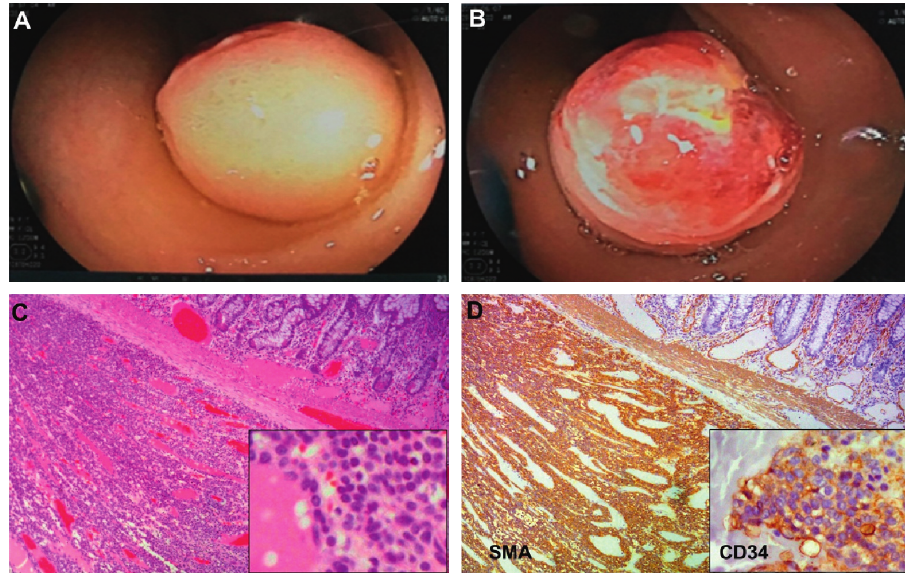
Figure 2: Representative images of an ileal glomus tumor. (a-b) Double-balloon enteroscopy revealed a protruded tumor with an ulcer surface. (c-d) Histological findings. (c) The tumor developed in the submucosal layer, composed of uniform glomus cells with round nuclei and amphophilic to eosinophilic cytoplasm arranging in nests, sheets, and trabeculae separated by branching vessels. Hematoxylin and eosin staining; original magnification x40 (box, x200). (d) Tumor cells were positive for SMA and CD34 (box). Immunohistochemistry staining; original magnification x40 (box, x200).